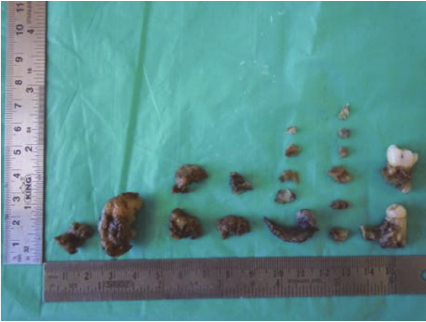
Figure 2: Gross specimen shows multiple bits of hard and soft